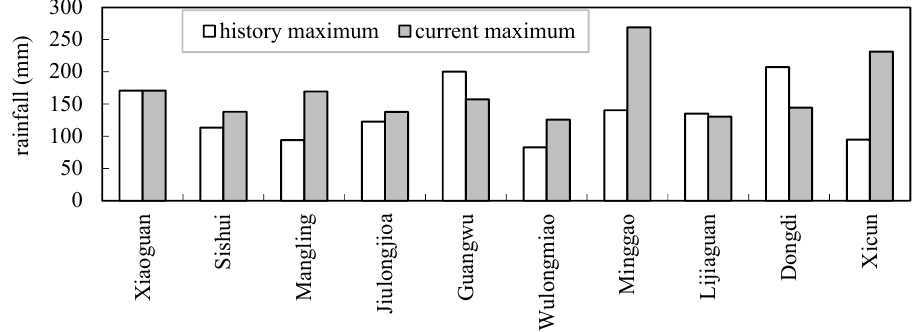
Figure 4. The maximum 24 h rainfall of ten reference stations between historical and “7.20” rainstorms.